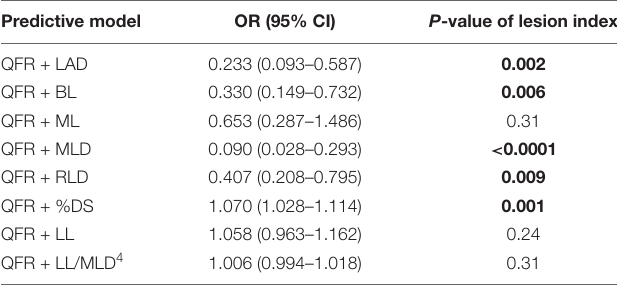
TABLE 3 | Logistic regression model with a single lesion parameter added to QFR.